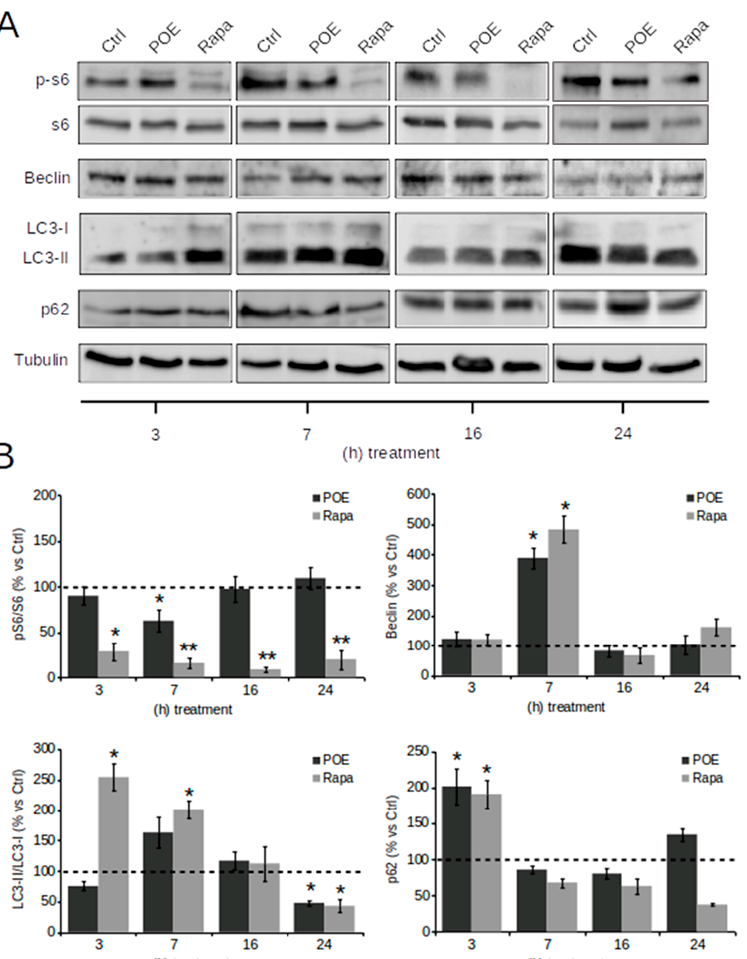
Figure 3. The effect of POE on autophagy flux activation in HepG2 cells. ( A ) Representative images of Western blot analysis of all the assayed protein markers of autophagy detected in HepG2 cells treated with POE (7.2 μ g/mL), cells treated with Rapa (0.5 μ M), or untreated cells (Ctrl). ( B ) Quantification of signals determined by densitometry analysis of at least three independent experiments. Error bars represent standard errors. * p < 0.05; ** p < 0.01 vs. untreated control cells (Ctrl; indicated by the dotted line). Kruskal–Wallis test. Pairwise comparisons were performed using Conover test.